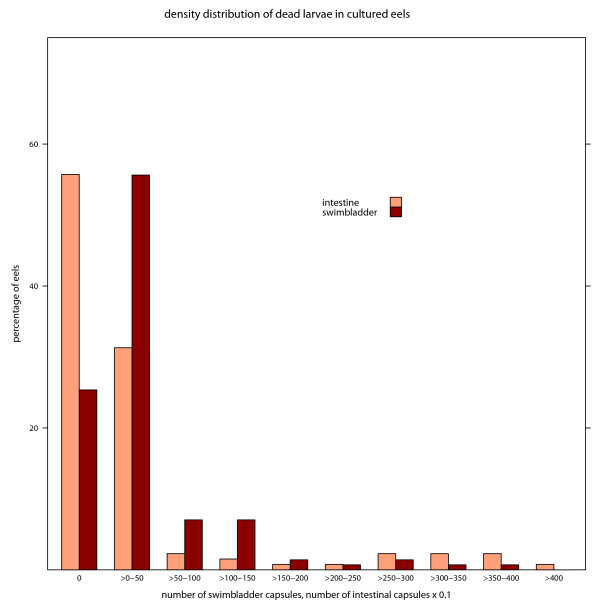
Frequency distribution of dead A. crassus in the intestinal and swimbladder-wall of Japanese eels. Observed frequency distribution of dead, encapsulated A. crassus in the wall of the swimbladder (n = 141) and the intestine (n = 122), note that the number of intestinal capsules has been transformed by a factor of 0.1 to fit the values for swimbladder capsules.